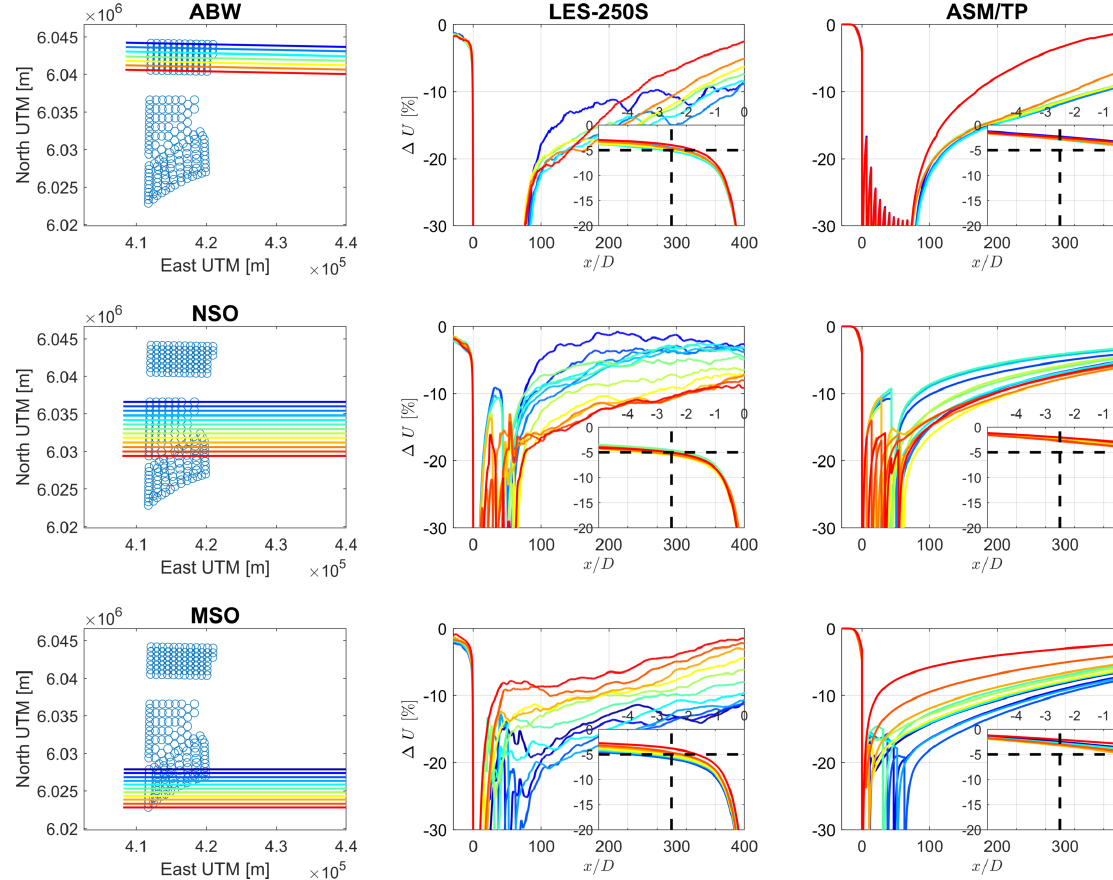
Figure 8. The percentage of wind speed reduction as a function of distance from the front row turbine corresponding to the wakes and upstream (insets) of the ABW ( top ), NSO ( middle row ) and MSO ( bottom ) wind farms according to LES stable (columns 2 and 4) and ASM stable (columns 3 and 5) cases. The first column of panels illustrates the positions to which the curves in the other panels pertain based on the line coloring. For example, the blue curves in the top row correspond to the wind speed reduction along a line through the uppermost row of the ABW wind farm. The insets show those same lines but up to 5 D upstream of the first wind